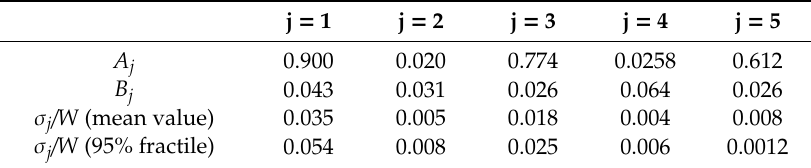
Table 1. Parameters for the Gaussian-shape spectrum SF(f,f p ) [42]. Tabl e 1. Parameters for the Gaussian-shape spectrum SF(f,f p ) [42].